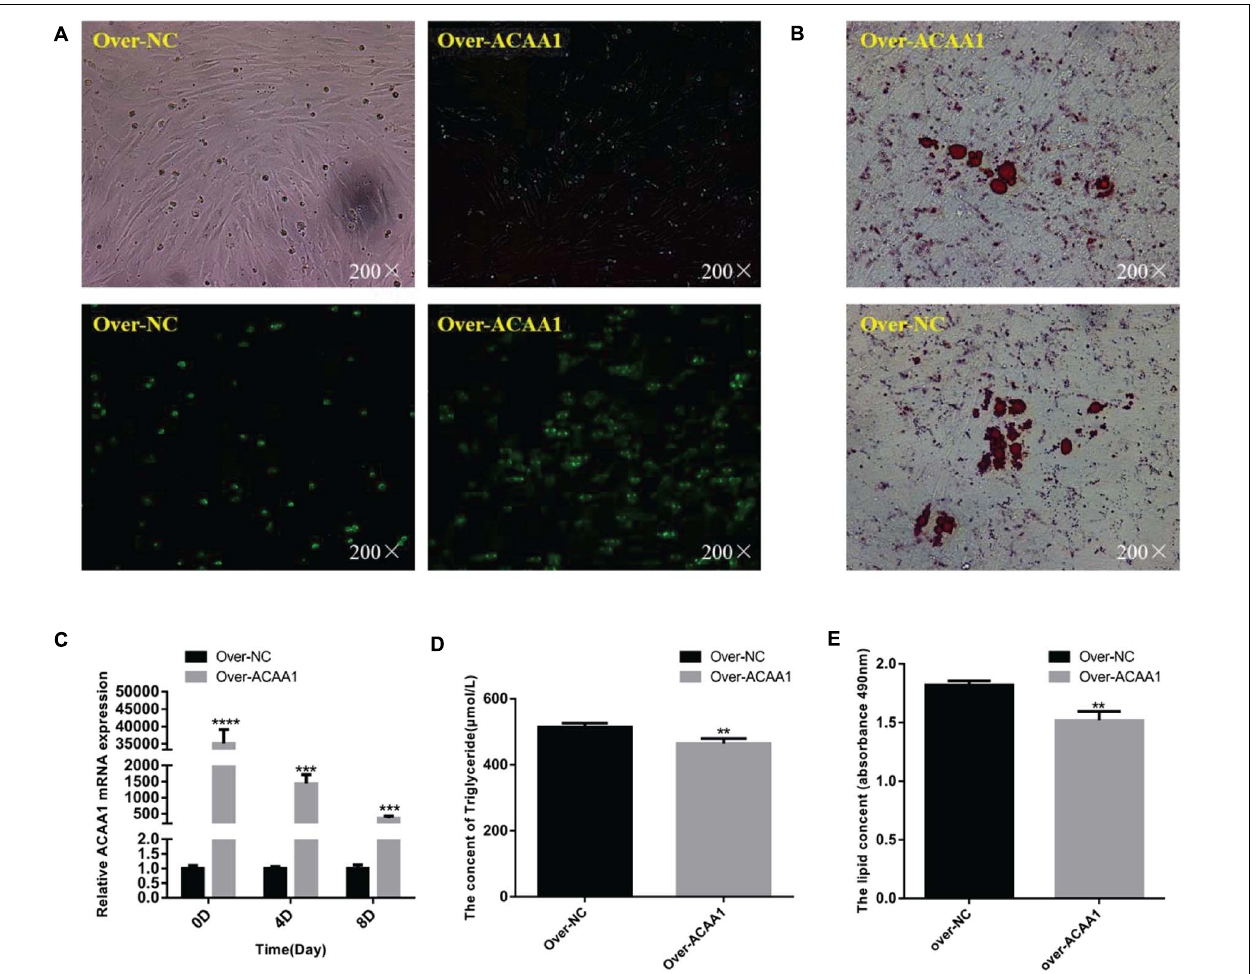
FIGURE 4 | ACAA1 overexpression decreases lipid accumulation and the triglyceride content in preadipocytes. (A) Determination of the transfection efficiency of the ACAA1 overexpression plasmid (200 × ). (B) After 8 days of differentiation, the cellular lipid droplets were stained with oil red O (200 × ). (C) ACAA1 mRNA expression was assessed after cells were transfected with the ACAA1 overexpression or the NC plasmids on days 0, 4, and 8 of adipogenic differentiation. The expression in the over-ACAA1 group was significantly higher than that in the control group (**** p < 0.01 and *** p < 0.001). The difference was largest in the early stage of cell differentiation. (D) After 8 days of induction, the triglyceride content in the over-ACAA1 group was significantly lower than that in the control group (** p < 0.01). (E) The lipid droplet content measured at 490 nm after 8 days of induction in the over-ACAA1 group was significantly lower than that in the control group (** p < 0.01).